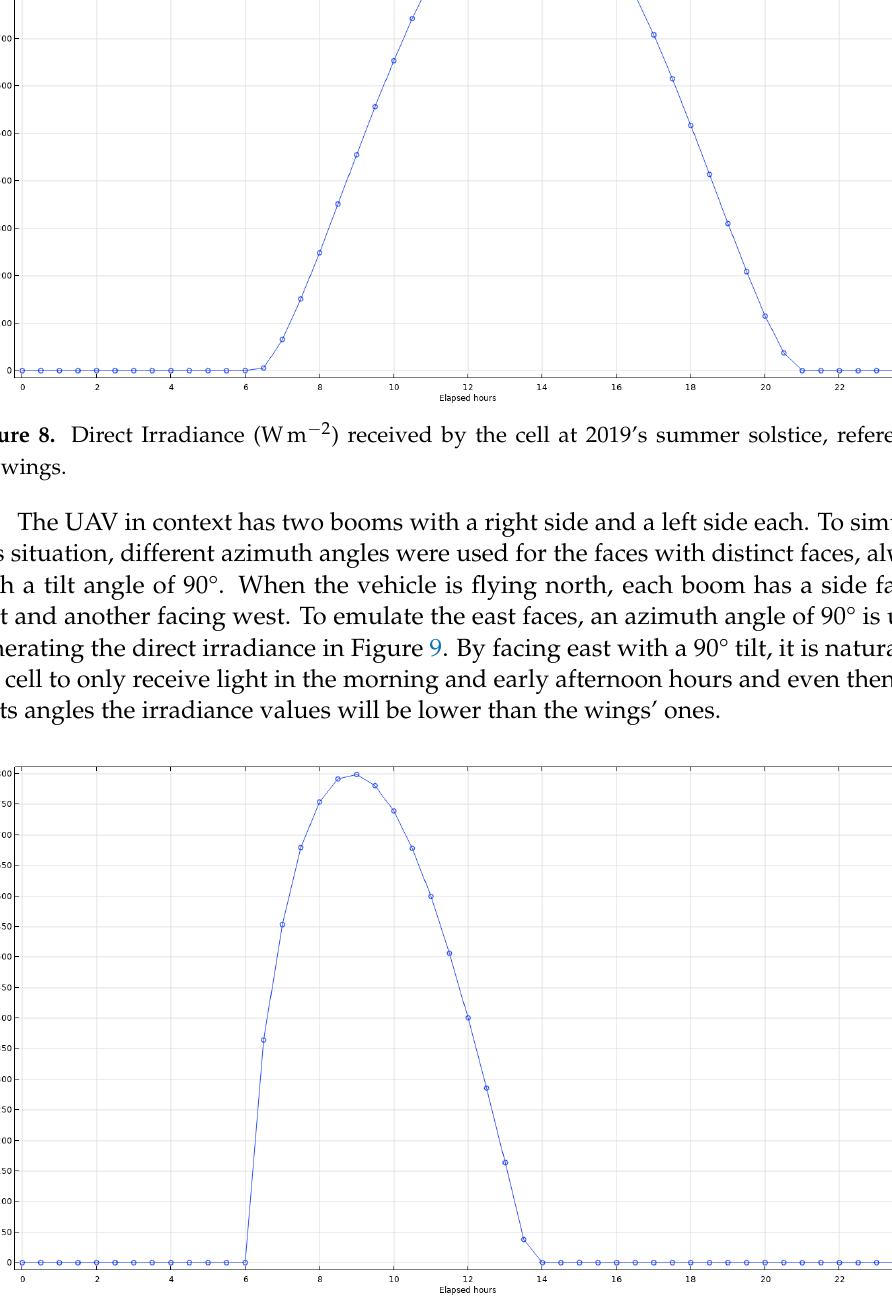
Figure 9. Direct Irradiance (Wm − 2 ) received by the cell at 2019’s summer solstice, referent to the boom’s east